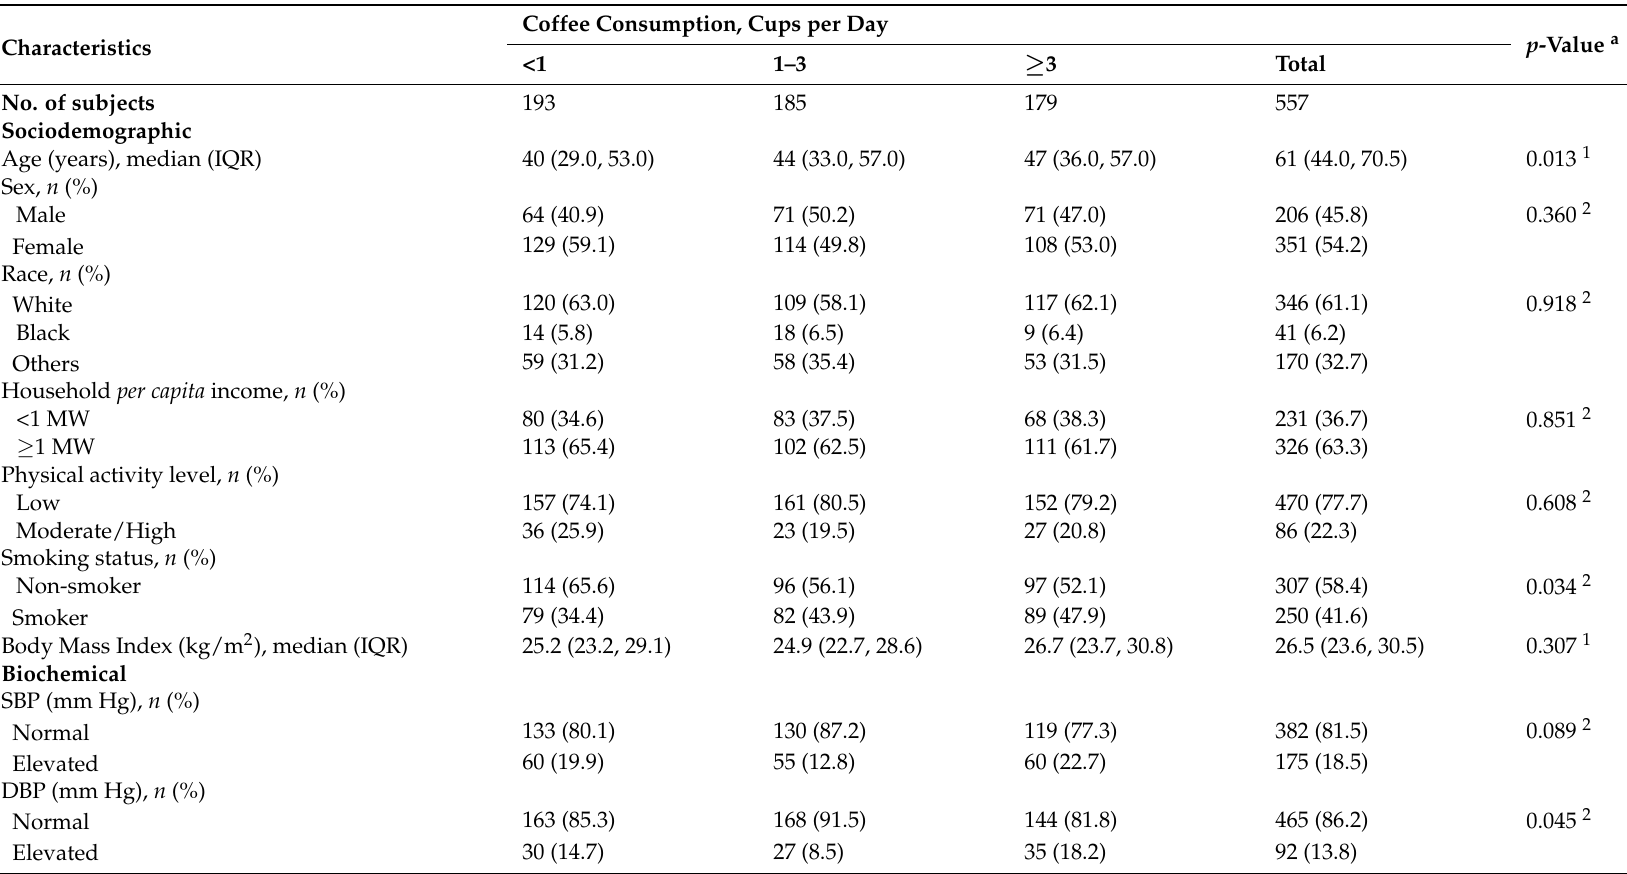
Table 1. General characteristics of the Health Survey of S ã o Paulo (ISA-Capital) population according to category of coffee consumption. S ã o Paulo, Brazil, 2008/09.